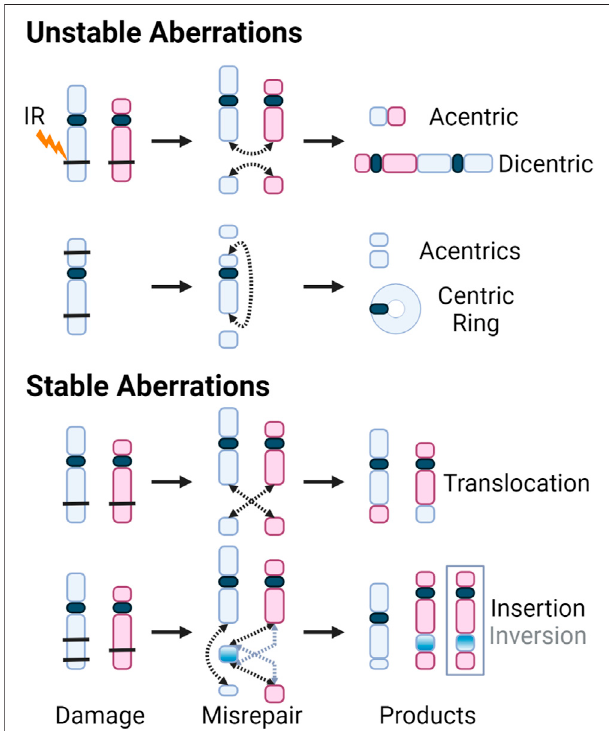
FIGURE 8 | DSBs caused by exposure to IR (black bars) shown on chromosomes with centromeres (blue and red, and dark blue, respectively). Dotted arrows indicate where the breaks rejoin. Products of the various misrepair scenarios include unstable aberrations: acentric and dicentric chromosomes,centricrings;andstableaberrations: translocations, aswellas insertions and inversions. For insertions and inversions, black arrows show wherethe fragments joinduring an insertion, and grey arrows show where the inverted chromosomal fragment joins. The inversion is further illustrated by invertingthe colorgradient of theinsertedchromosomefragmentand the fi nal inversion product is enclosed in a grey box.